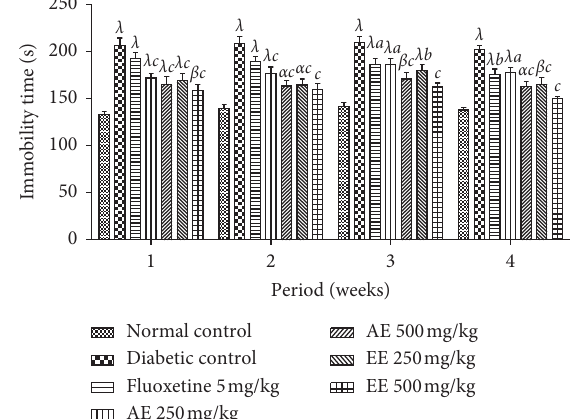
Figure 12: Effects of the aqueous (AE) and ethanol (EE) extracts of Dissotis thollonii on the immobility time of mice in the tail sus- pension test during 5min. Values are expressed as mean ± SEM for six animals and analyzed by two-way ANOVA followed by Bon- ferroni post hoc test. α p < 0 . 05, β p < 0 . 01, λ p < 0 . 001 when com- pared with the normal control and a p < 0 . 05, b p < 0 . 01, c p < 0 . 001 when compared with the diabetic control; s